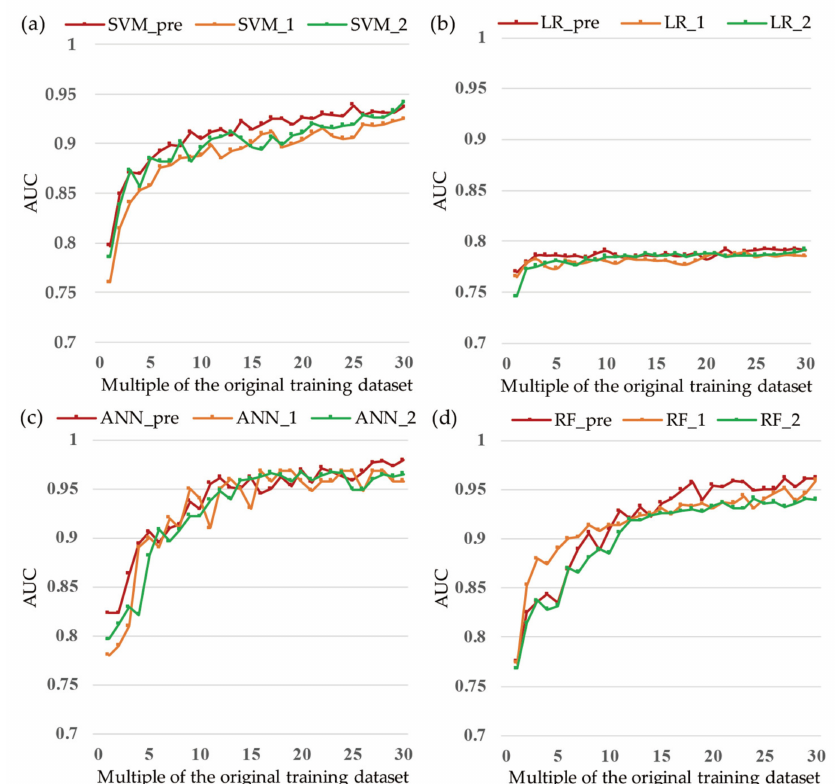
Figure 13. Different segmentation comparisons for several models using validation with different datasets (_pre means the previous segmentation and _1 and _2 mean the two different segmentations).